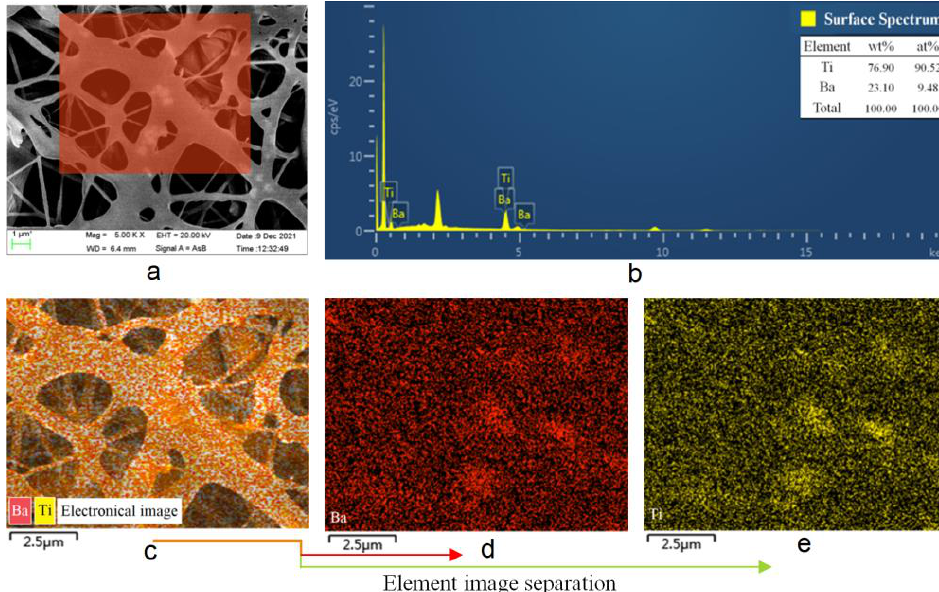
Figure 3. Distribution of BaTiO 3 in polyurethane fiber membrane prepared by coaxial spinning technology. Among them, ( a ) is the arrangement trend diagram of BaTiO 3 in polyurethane fiber, ( b ) shows the proportion diagram of Ti and Ba elements, ( c ) is the distribution diagram of Ti and Ba elements, and ( d , e ) are the distribution diagrams of Ba and Ti elements respectively.